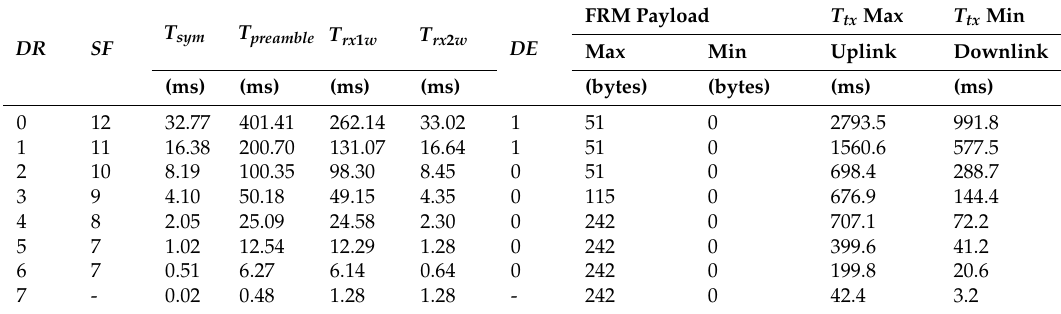
Table 6. Summary of values for T tx , T rx 1 w and T rx 2 w , along with relevant parameter settings. We